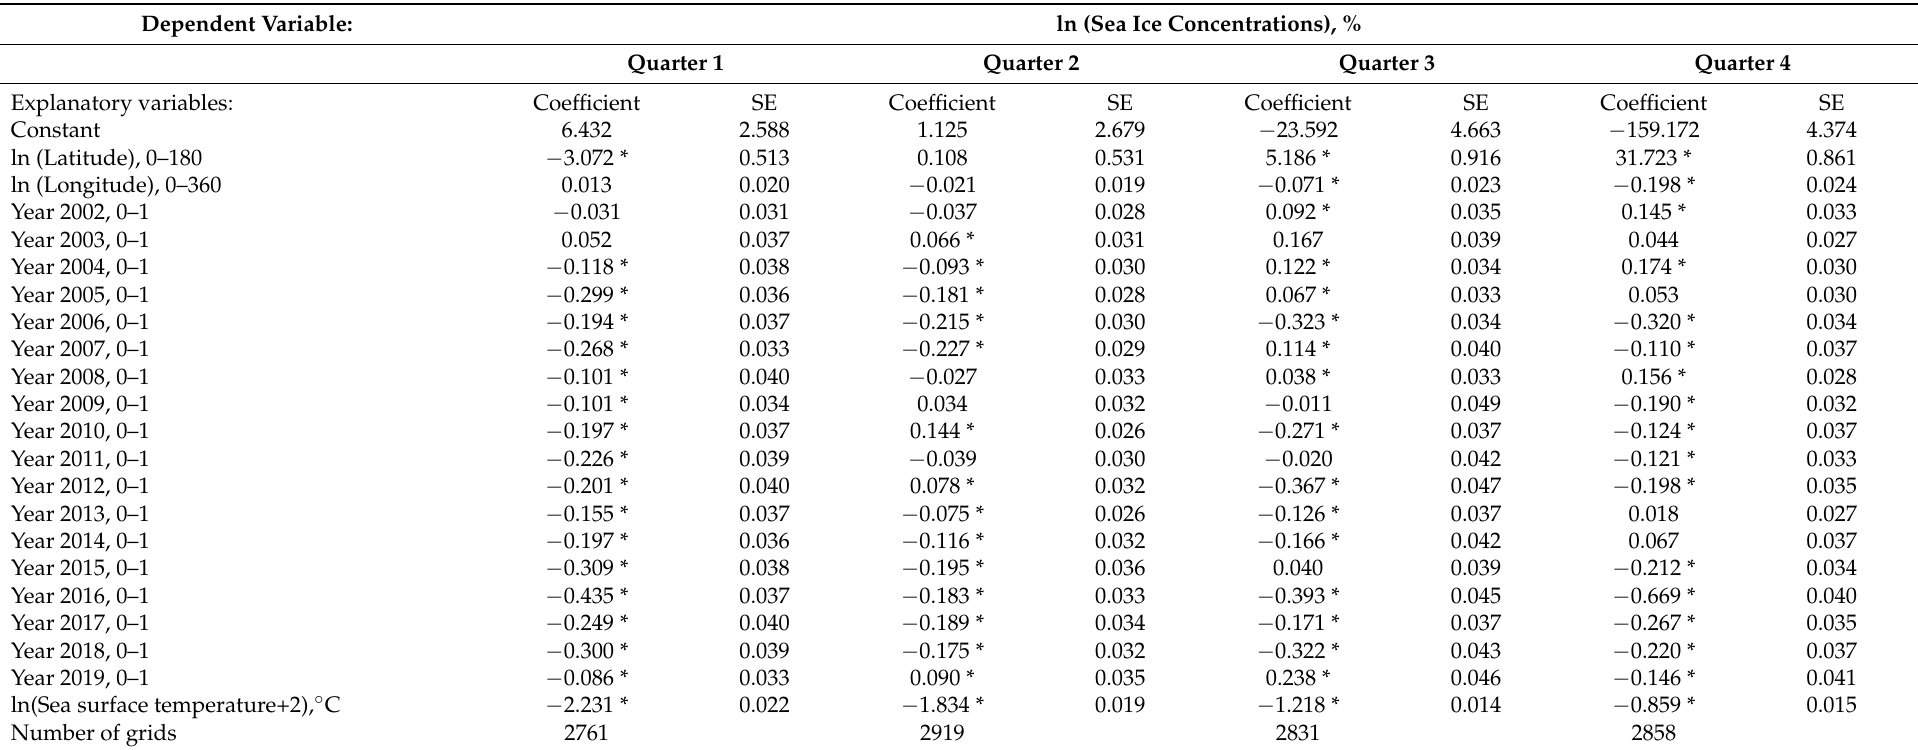
Table 5. Efficient estimates of static random effects models using quarterly data for 2000–2019 for 1 × 1 degree grids on sea ice concentrations in the Northern hemisphere explained by geodesic variables, time indicators for the years, and sea surface temperatures 1,2